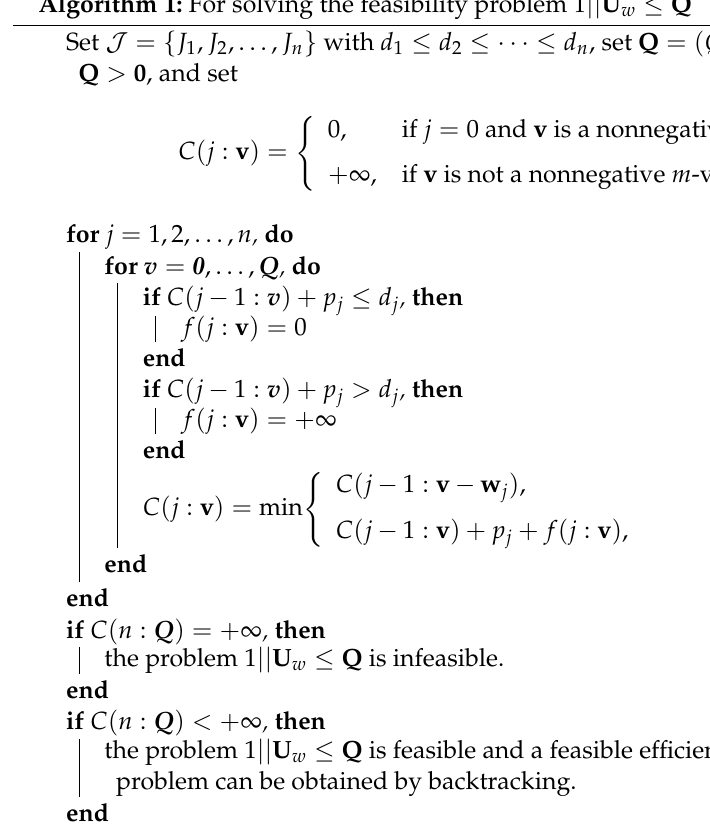
Algorithm 1: For solving the feasibility problem 1 || U w ≤ Q